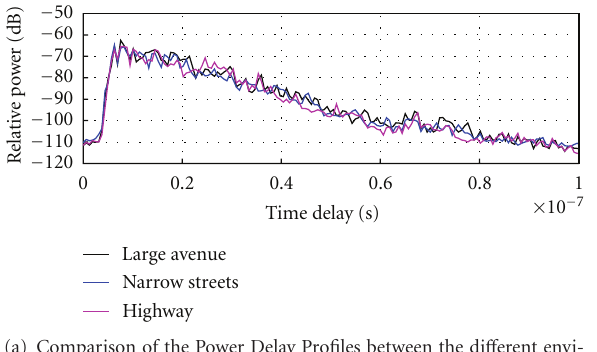
(a) Comparison of the Power Delay Profiles between the di ff erent envi- ronments for 3 passengers. No significant di ff erences can be observed between the di ff erent environments